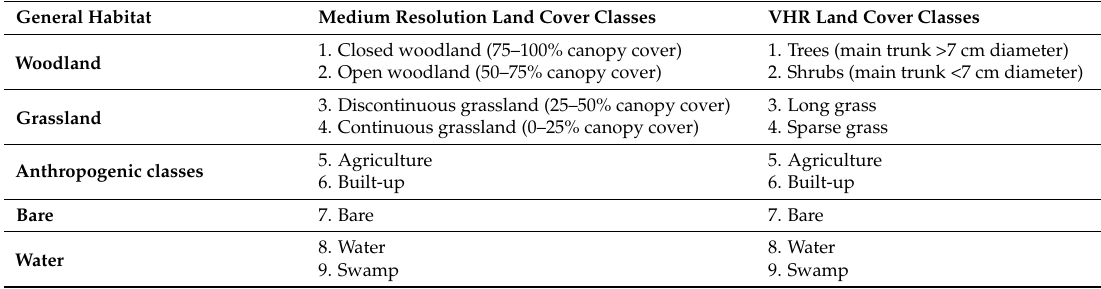
Table 1. Classification nomenclatures for medium and VHR imagery derived land cover maps. General Habitat